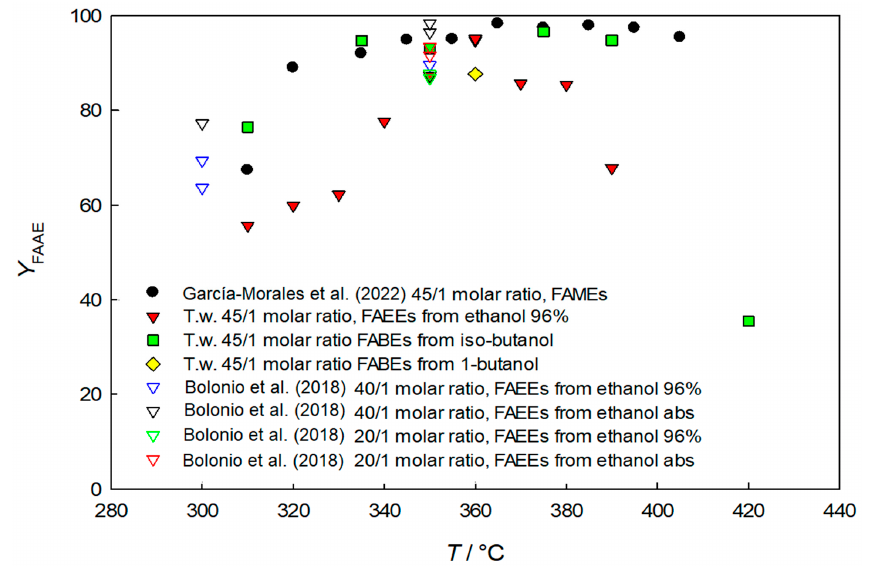
Figure 4. Production of fatty acid alkyl esters from waste beef tallow with different alcohols and feedstock ratios.